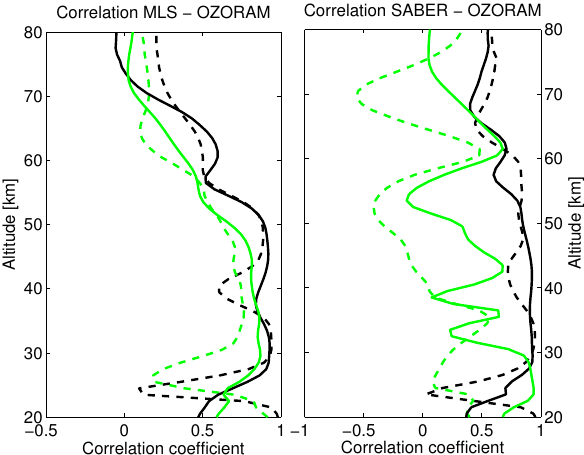
Fig. 9. Correlation of the OZORAM-JPL (solid lines) and the OZORAM-HIT (dashed lines) datasets to the satellite instruments MLS (left panel) and SABER (right panel). The correlation has been calculated separately for the day time (green lines) and the night time measurements (black